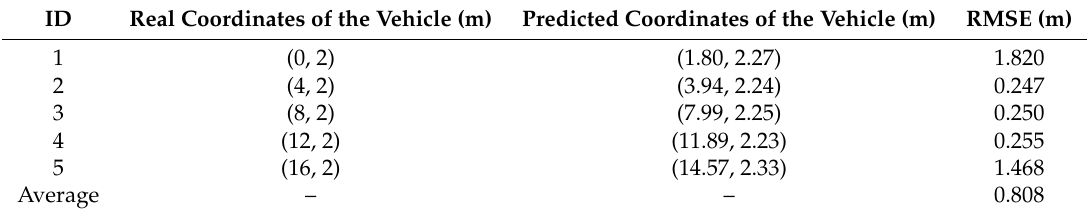
Table 2. The localization results in the X-O-Y plane. RMSE: root mean square